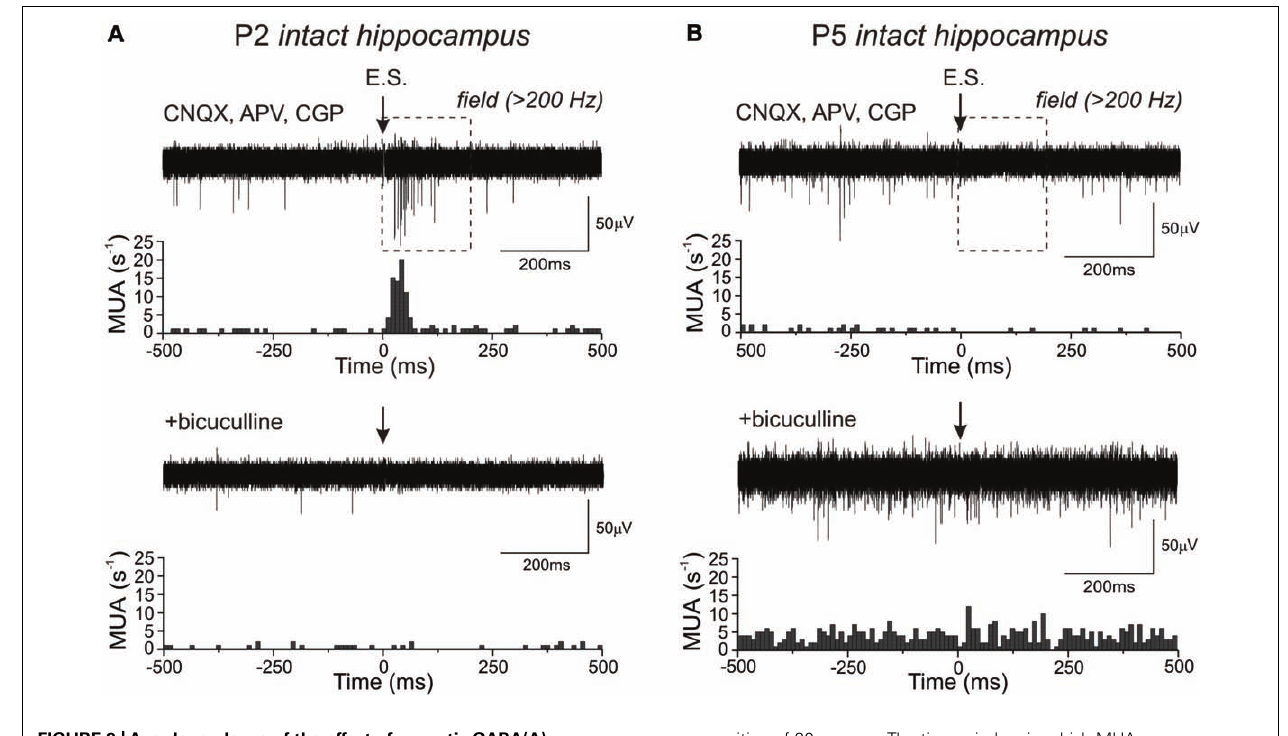
FIGURE 3 |Age-dependence of the effect of synaptic GABA(A) receptors activation on MUA frequency in the intact hippocampus in vitro . (A,B) Extracellular recordings of MUA responses evoked by electrical stimulation (E.S.) in the presence of ionotropic glutamate and GABA(B) receptor antagonists (CNQX, APV, CGP55845) in CA3 pyramidal cell layer in P2 (A) and P5 (B) intact hippocampi; each example shows the